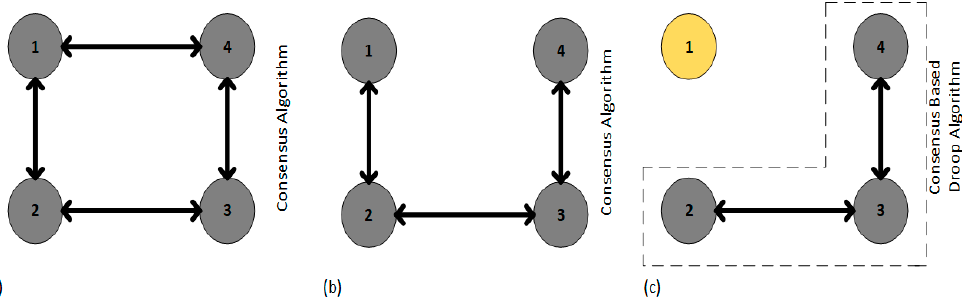
Figure 6. Proposed DC Microgrid experimental setup for case study.